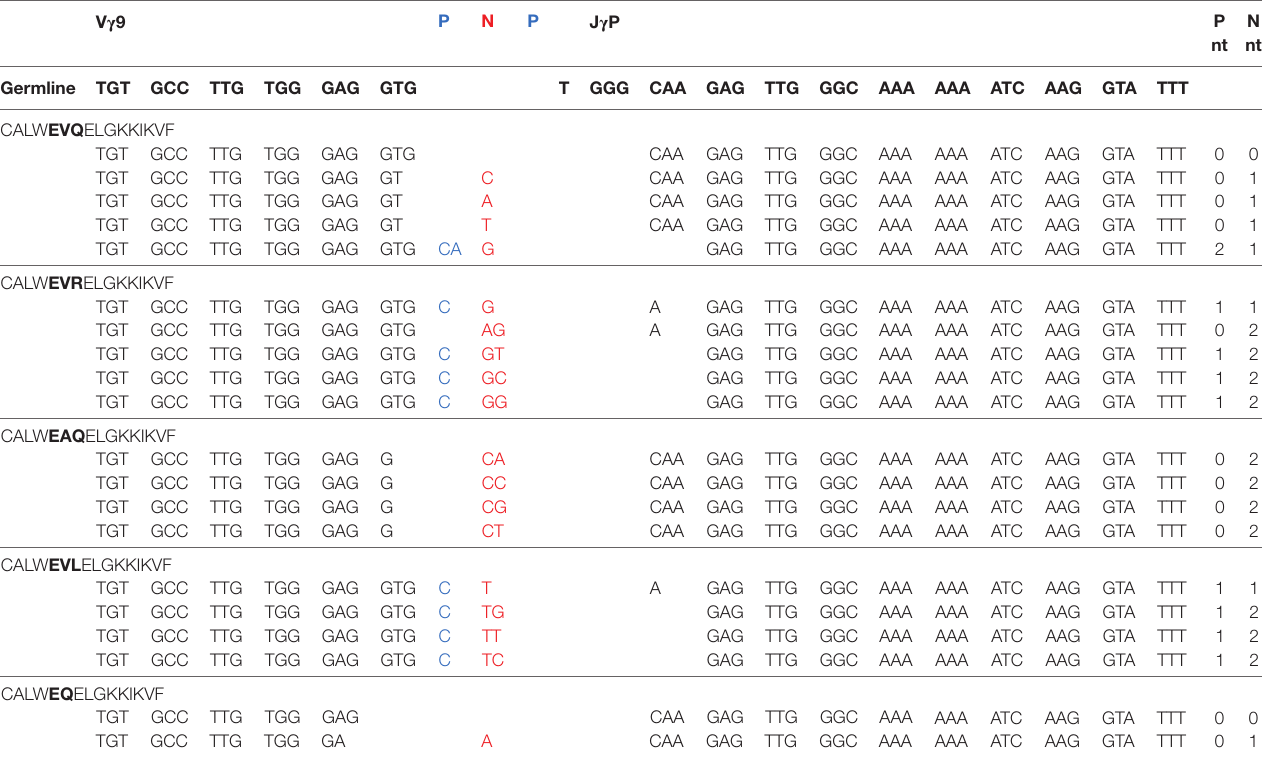
V γ 9 and J γ P gene segments are subject to nuclease activity, non-templated (N) nucleotide addition, and incorporation of palindromic (P) nucleotides, during recombination. Above are shown some of the possible different nucleotide sequences observed that generate the same CDR3 amino acid sequences, for five of the most common public V γ 9 sequences. N-nucleotides are shown in red and P-nucleotides are shown in